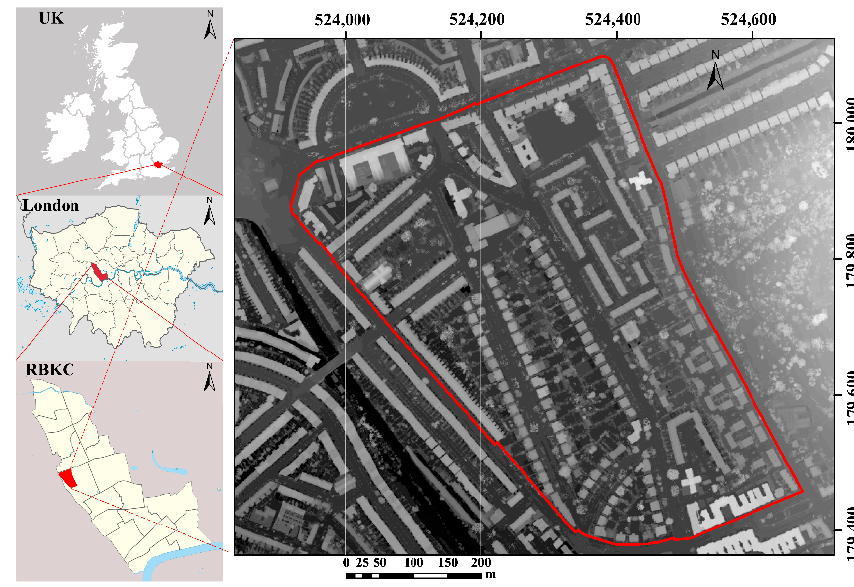
Figure 1. The DSM map of the study area in RBKC, west London, England [55].